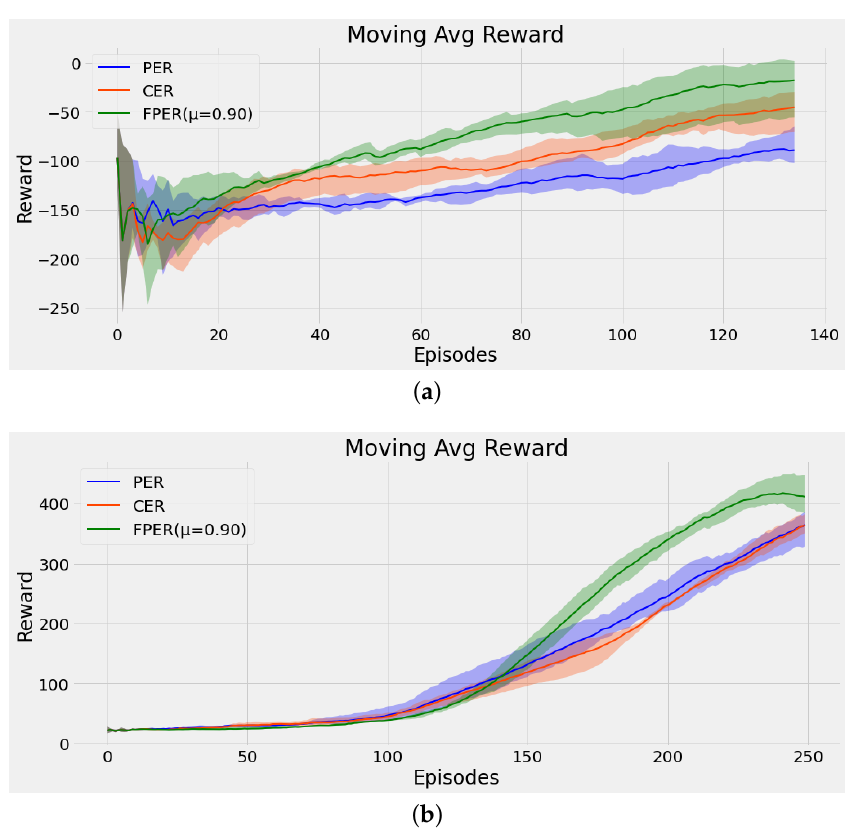
Figure 3. Learning curves in discrete control tasks. The shaded region represents the standard deviation of the average evaluation over five trials, and the thick line represents the mean of the average evaluation over five trials. ( a ) LunarLander-v2. ( b )